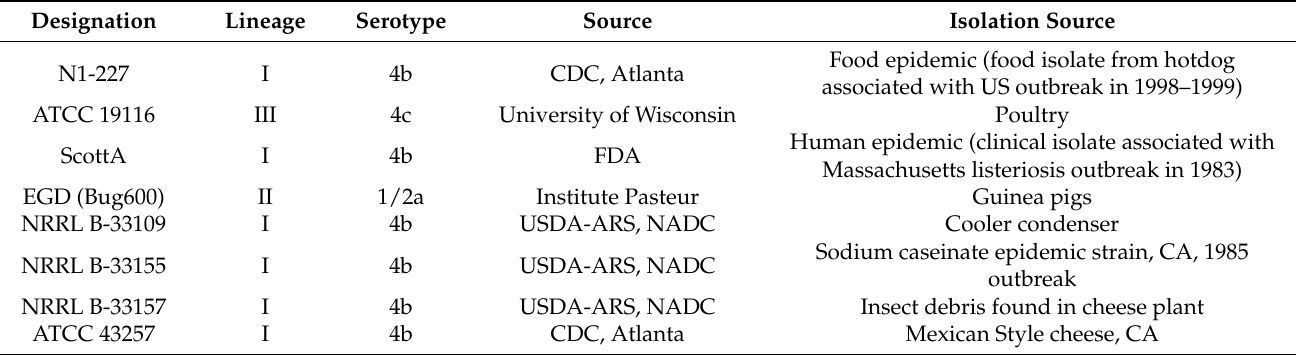
Table 1. L. monocytogenes strains used in this